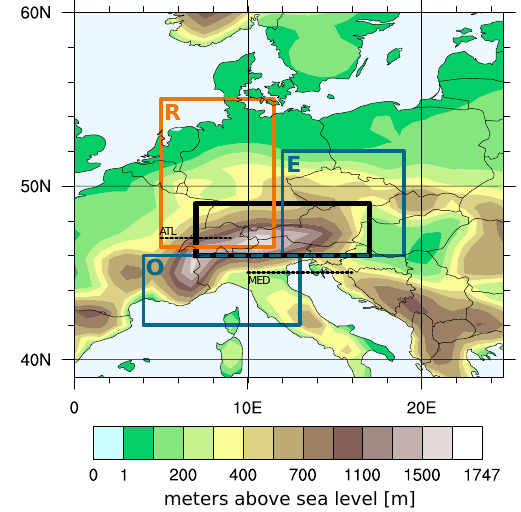
Figure 2. The three boxes used to automatically filter out the Vb cyclones from the total number of cyclones found by the tracking technique (Blender et al., 1997). O, E and R denote the origin, the end and the restriction box, respectively. The black box over the alpine region defines the area of interest for precipitation amounts. The two stippled black lines indicate the position of the two cross- sections used to calculate the moisture flux. The topography corre- sponds to the one implemented in